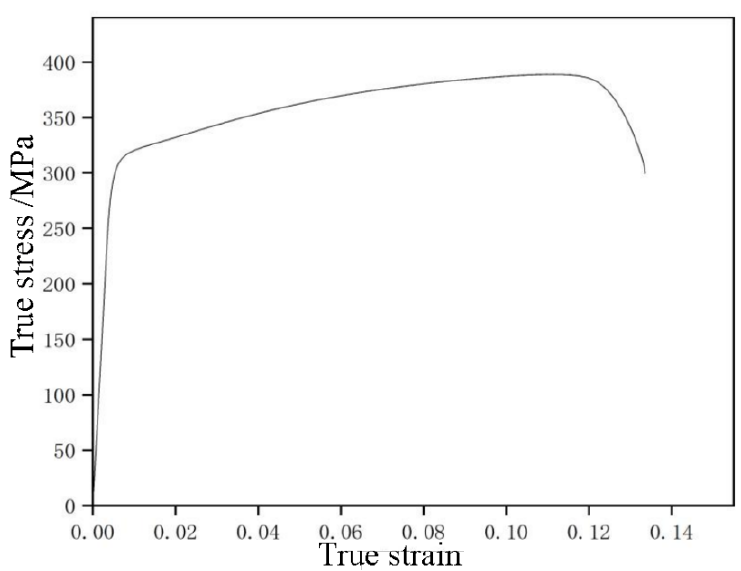
Figure 6. True stress – true strain curve of AL6061-T6.